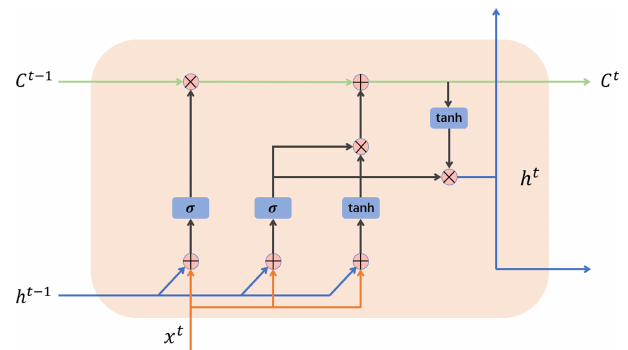
Figure 2. The internal structure of argcLSTM.